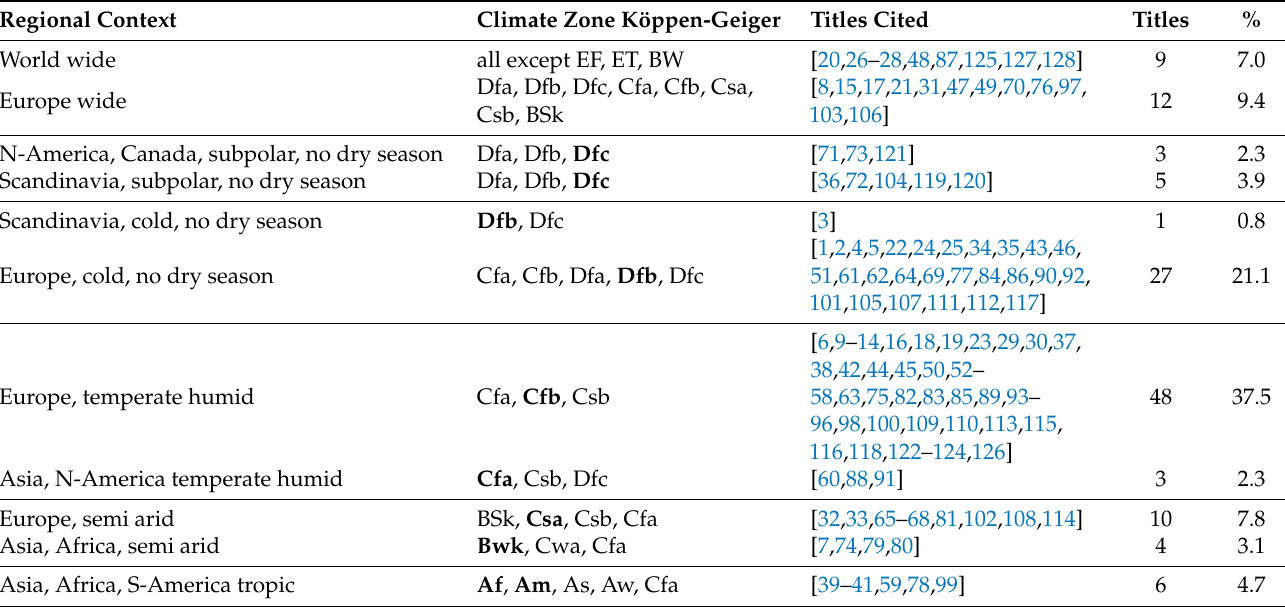
Table A1. Regional and climatic context of the 128 articles cited. Climate zones according to Reference